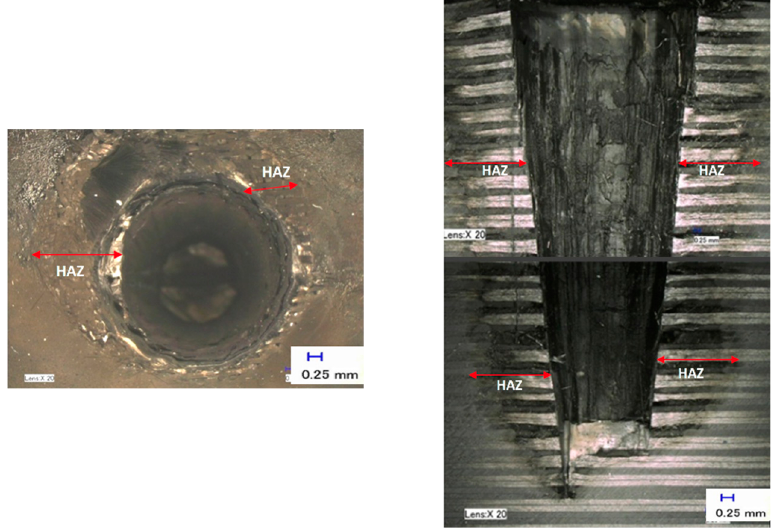
Figure 15. A typical example of assist gas pressure (8 bar) on overall hole depth, HAZ, and hole diameter.